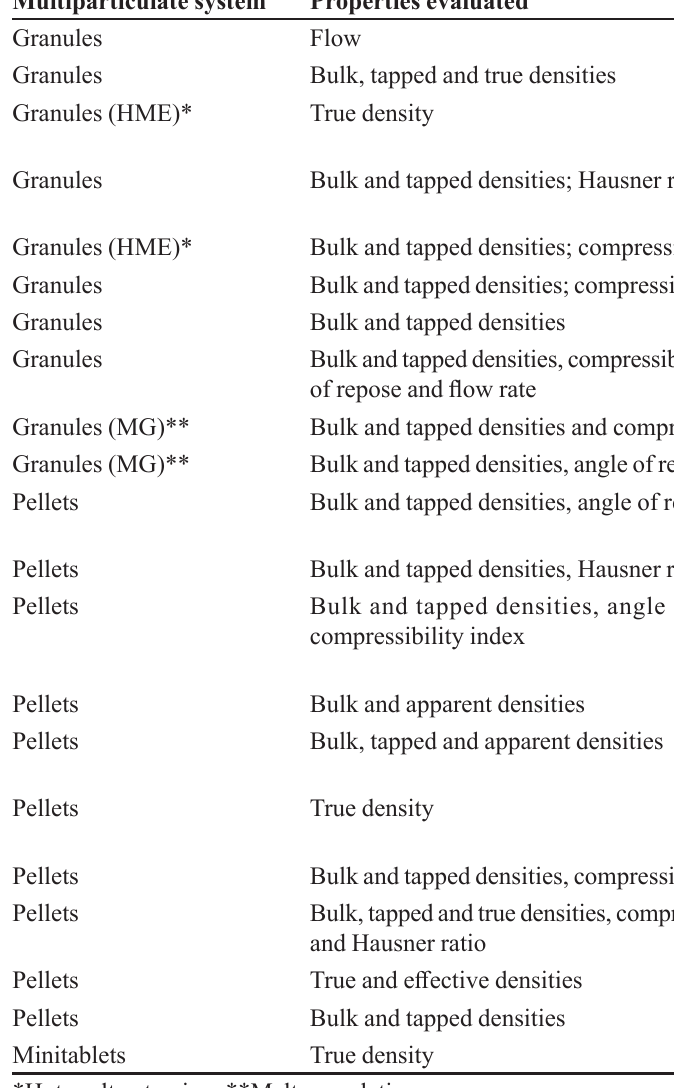
TABLE VI - Densities evaluated in multiparticulate systems Multiparticulate